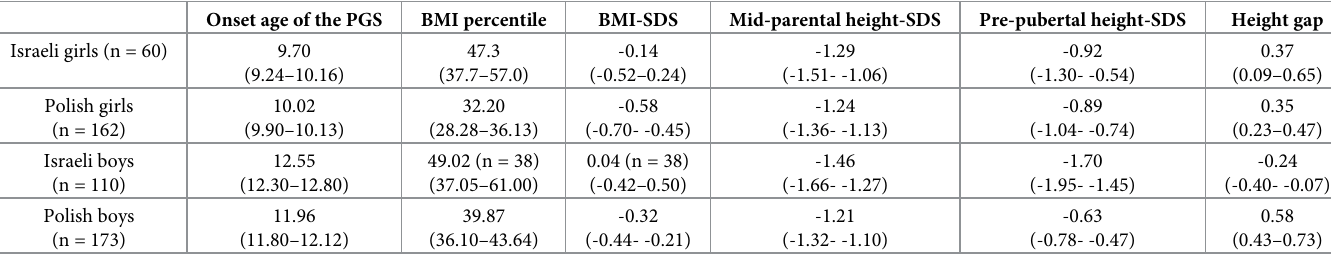
Table 1. Mean values (95% confidence interval) of the parameters used in the regression analysis. Onset age of the PGS BMI